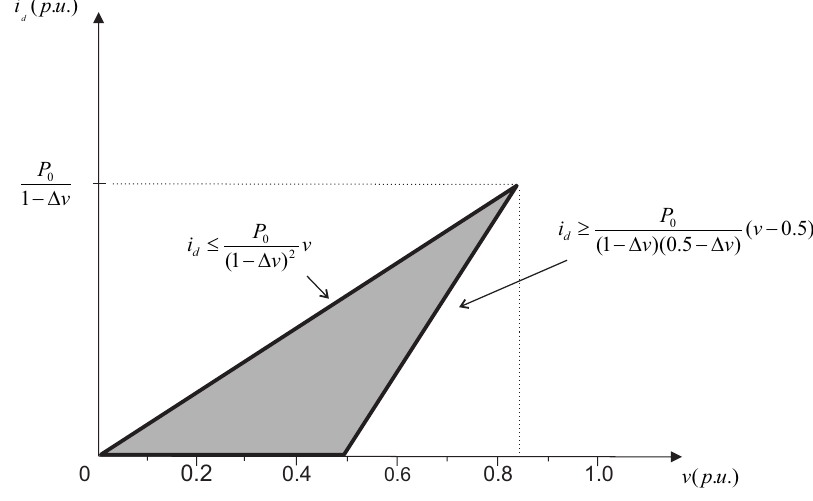
Figure 9. Spain GC active power limitation during FRT.